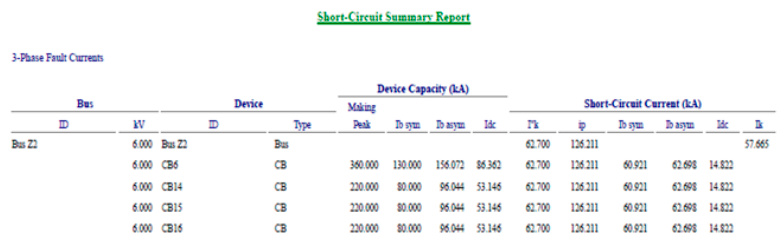
Figure 15. Three-phase fault current.